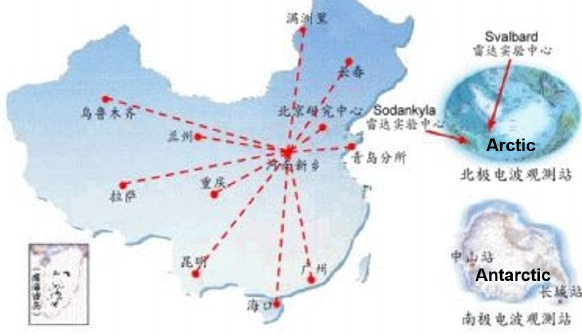
Figure 3. A map of the ionosonde and digisonde network operated by the